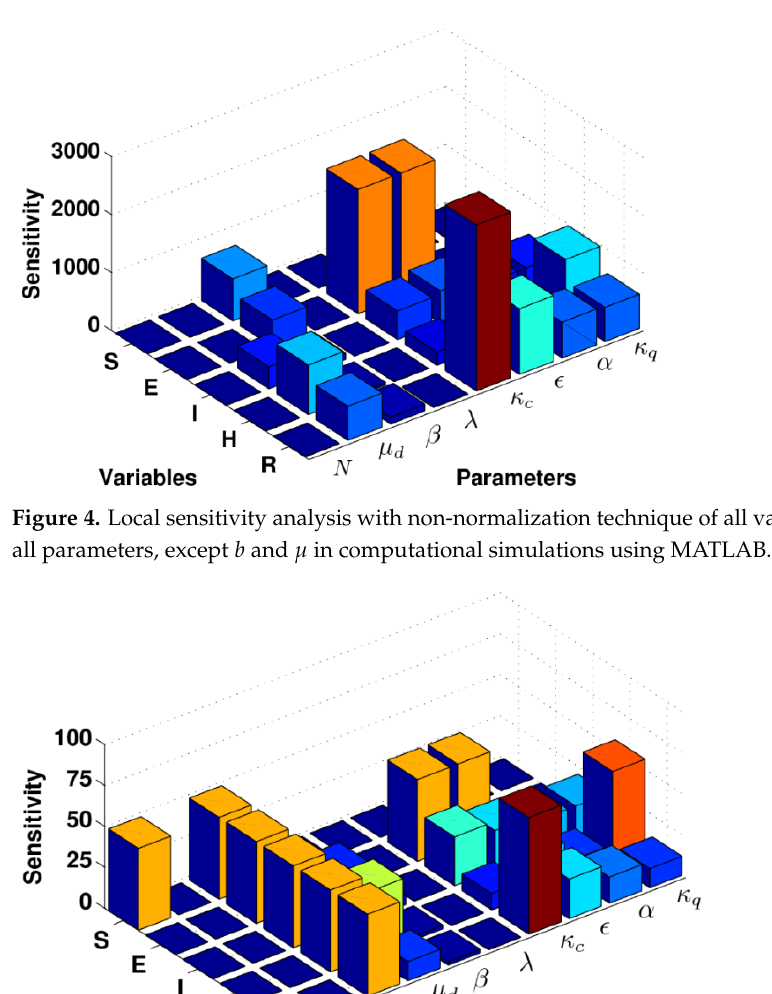
Figure 3. Local sensitivity analysis with non-normalization technique of all variables with respect to all parameters in computational simulations, using MATLAB. Parameters values are taken from Table 1.